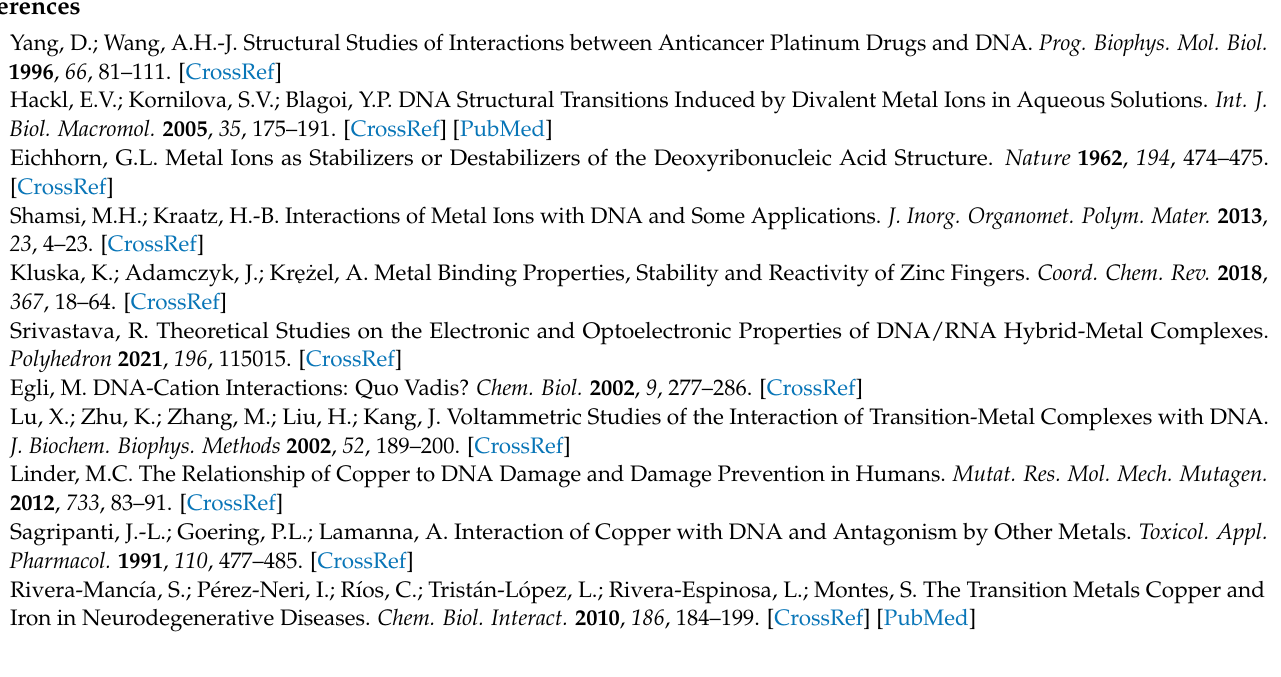
Figure S2: UV-Vis of Cu(enP)H 4 (TMP); Figure S3: 13 C NMR of Cu(enP)H 4 (TMP); Figure S4: 13 C NMR of TMP; Figure S5: 13 C NMR spectrum of enP; Figure S6: 31 P NMR of Cu(enP)H 4 (TMP); Figure S7: 31 P NMR of TMP, Figure S8: 31 P NMR of enP; Figure S9: EPR of Cu(enP)H UV-Vis of Cu(enP)H 4 (UMP); Figure S11: 13 C NMR of Cu(enP)H 4 (UMP); Figure S12: 13 C NMR of UMP; Figure S13: 13 C NMR spectrum of enP; Figure S14: 31 P NMR of Cu(enP)H 4 (UMP); Figure S15: 31 P NMR of UMP; Figure S16: 31 P NMR of enP; Figure S17: EPR of Cu(enP)H UV-Vis of Cu(enP)H 4 (CMP); Figure S19: 13 C NMR of Cu(enP)H 4 (CMP); Figure S20: 13 C NMR of CMP; Figure S21: 13 C NMR spectrum of enP; Figure S22: 31 P NMR of Cu(enP)H 4 (CMP); Figure S23: 31 P NMR of CMP, Figure S24: 31 P NMR of